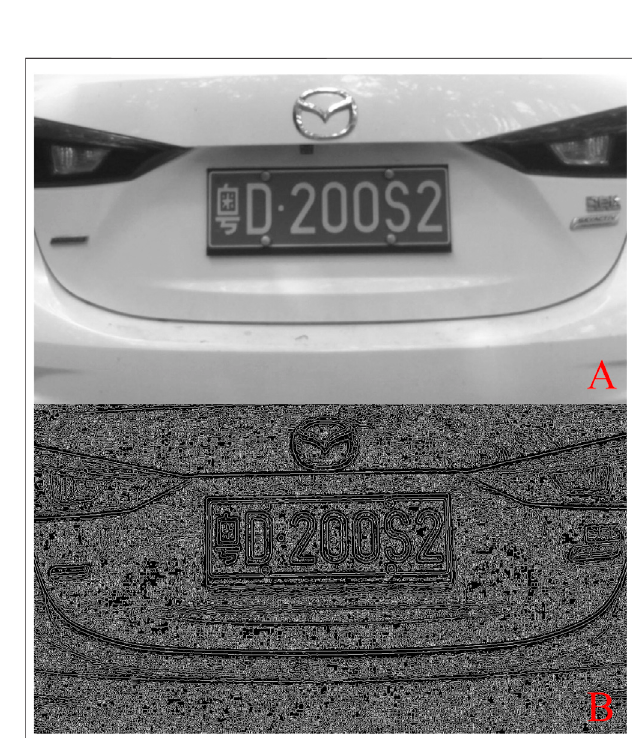
FIGURE 6| |Comparison images of edge detection. (A) was the original image, and (B) was the effect image after edge detection by using the SOBEL